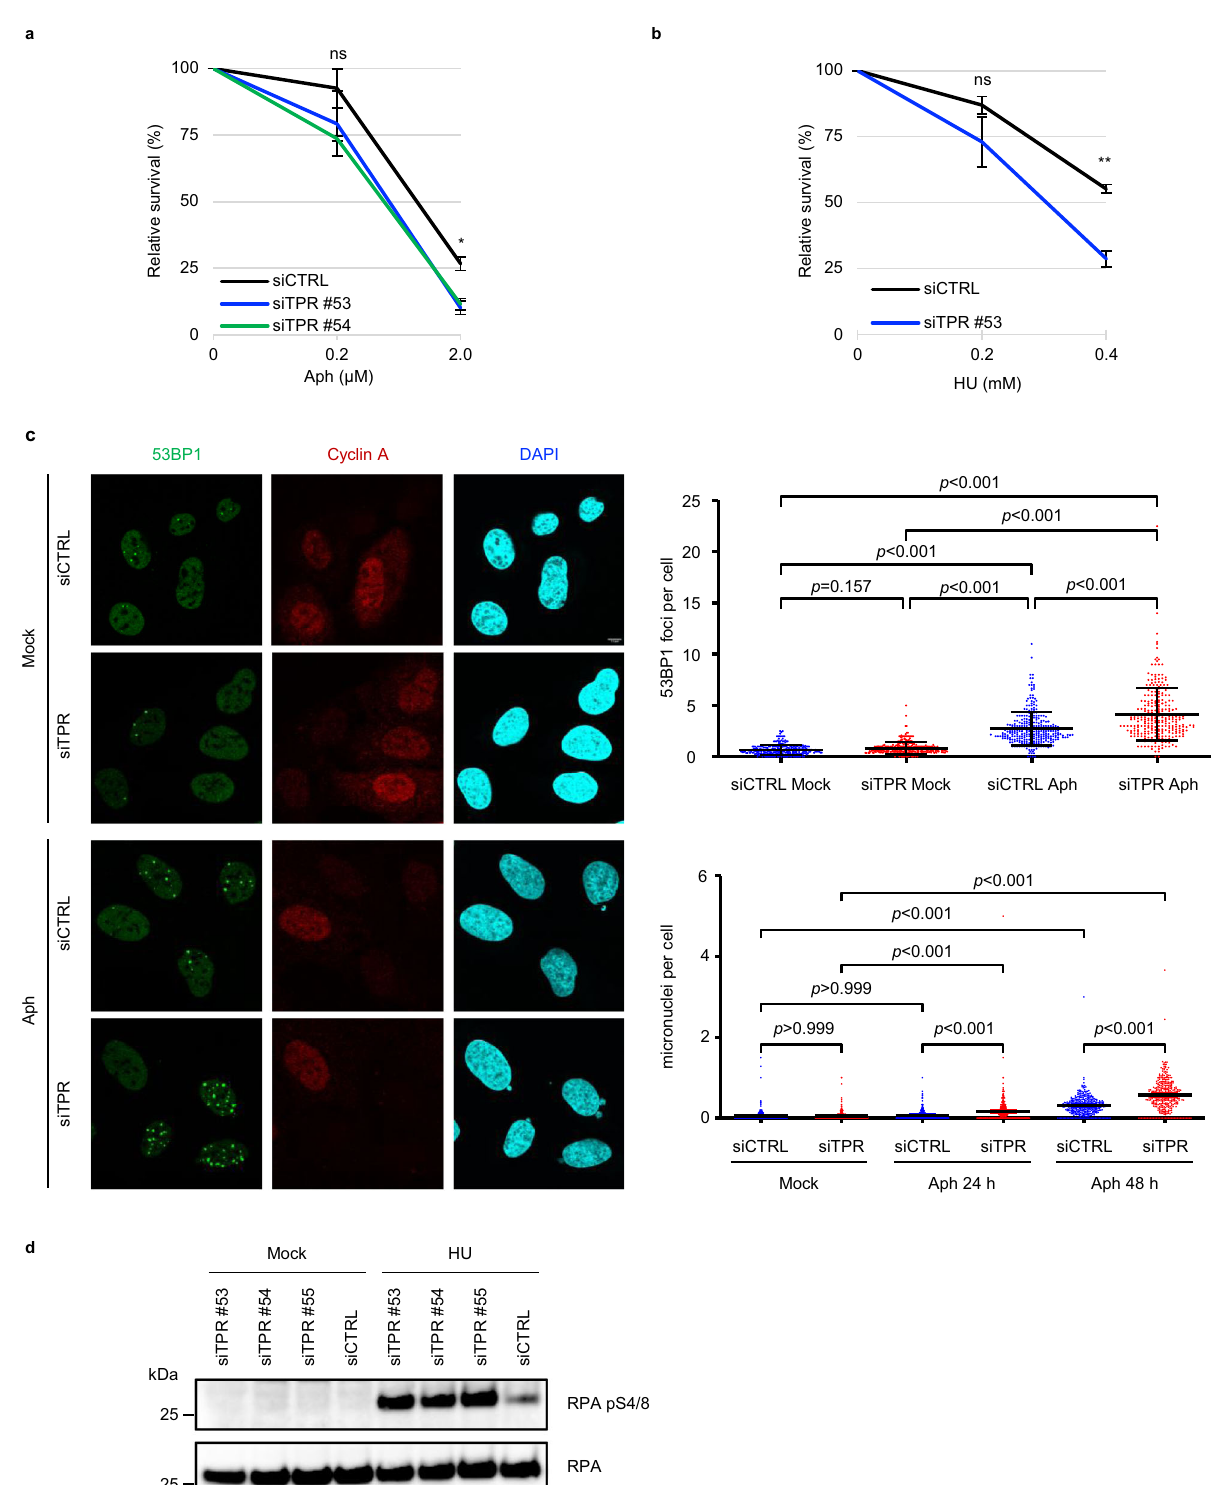
event that signals the presence of extended single-stranded DNA (ssDNA) 35 . Such 4-h exposure to 2 mM HU-evoked robust pRPA S4/8 in U-2 OS cells depleted of Tpr by 3 different siRNAs, respectively, in contrast to only a modest pRPA S4/8 signaling in control Tpr-pro fi cient cells (Fig. 1d). Simultaneously, we did not observe any differences in Chk1 and ATR protein levels or their phosphorylation between Tpr-depleted and control cells (Supple- mentary Fig. 1c,